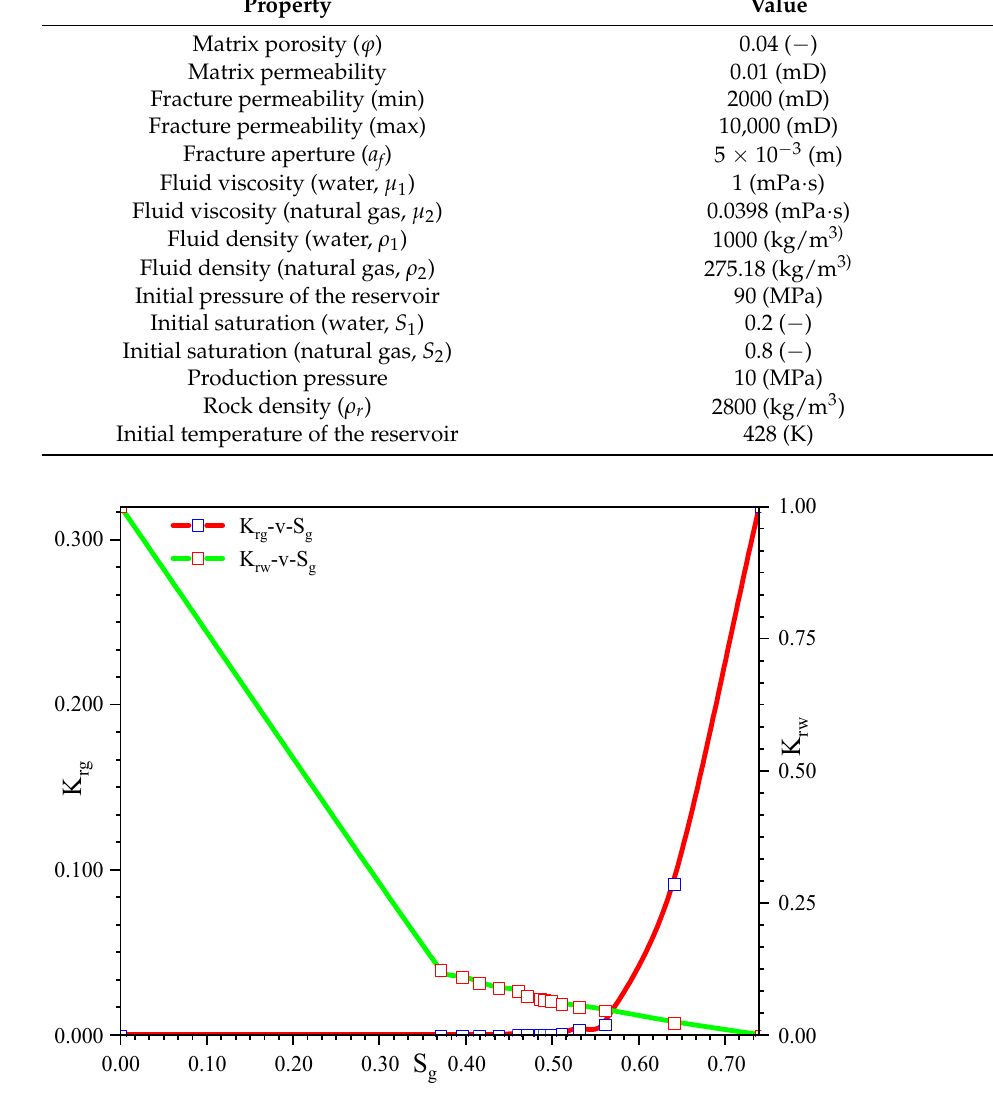
Figure 7. Gas–liquid two–phase permeability curve.